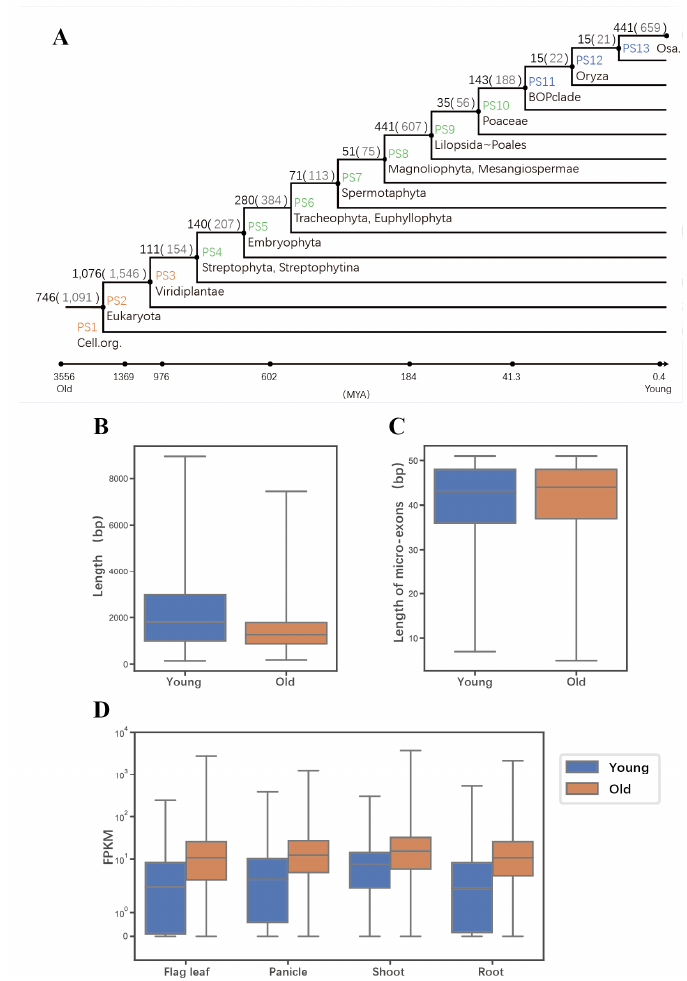
Figure 2. The evolutionary ages of micro-exons genes. ( A ) The phylogenetic tree shows the genes containing micro-exons in different evolutionary times, from phylostratum (PS)1 (single-cell organisms) to PS13 ( O. sativa ). There are two numbers on each branch: the numbers of genes corresponding to each level are outside the brackets, while the numbers of identified micro-exons are in brackets. The genes of PS1–3 are assigned as “old genes” while the genes of PS11–13 are “young genes”. ( B ) The comparison of coding sequence (CDS) lengths between the young genes and old genes. ( C ) The comparison of micro-exon lengths between the young genes and old genes. ( D ) The comparison of gene expression in four tissues between the young genes and old genes. FPKM represents pair-end fragments per kilobase of exon model per million mapped fragments. The blue color represents young genes and the orange color represents old genes.